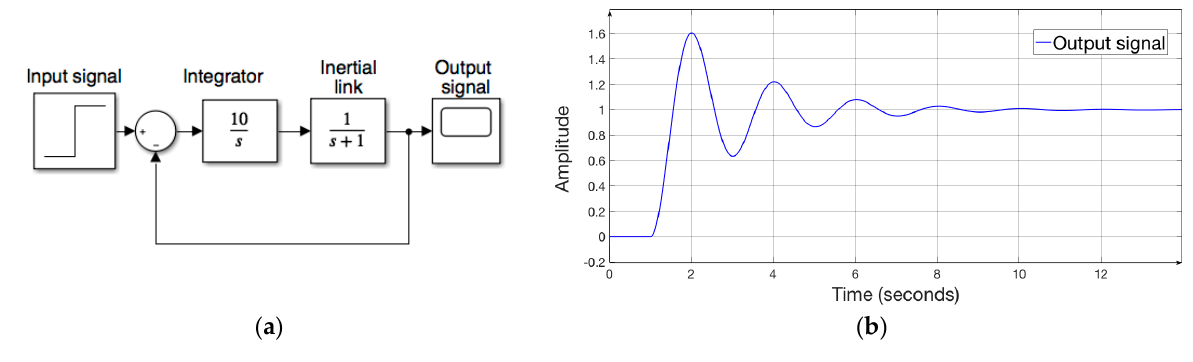
Figure 9. Scheme of a linear model ( a ) and processes in it ( b ).